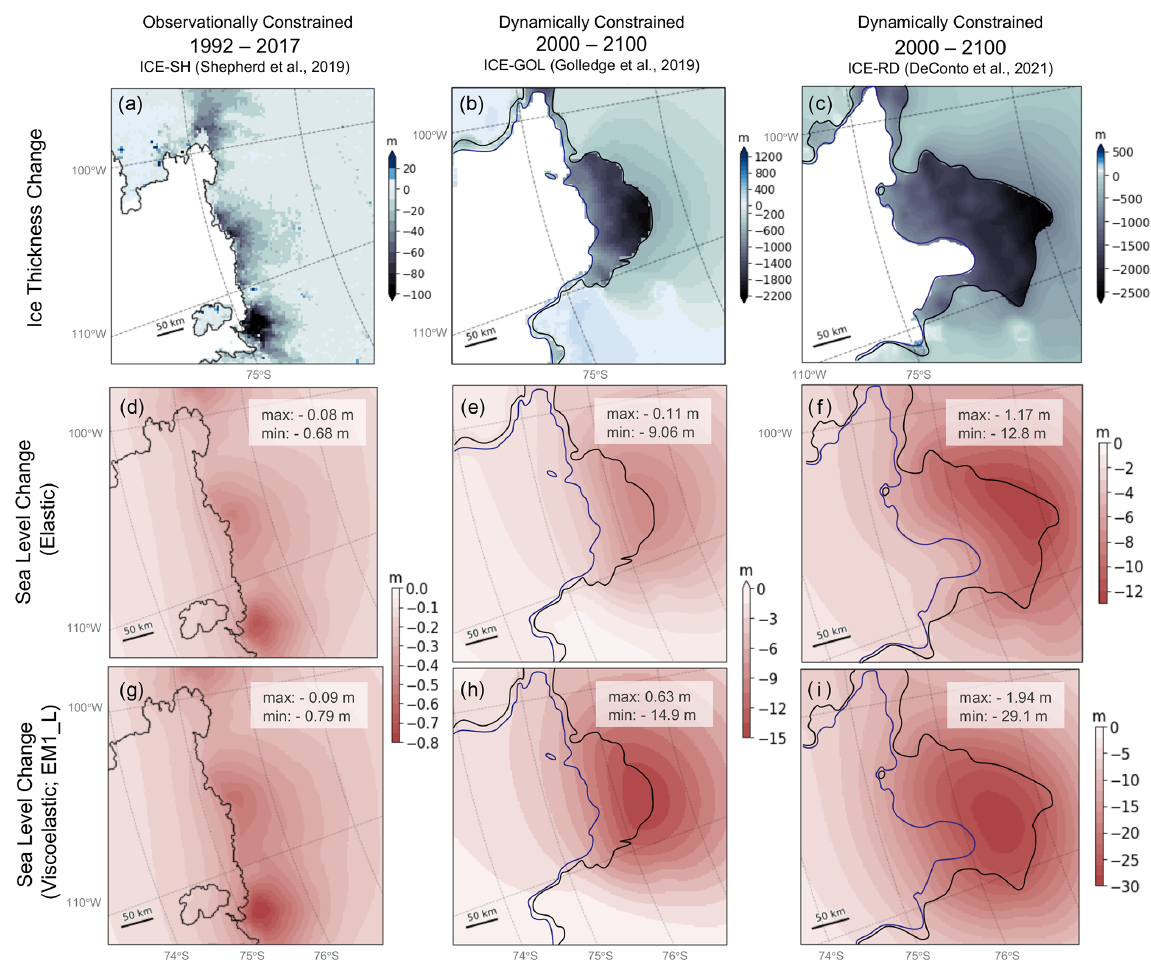
Figure 2. Ice loading scenarios and corresponding elastic sea-level predictions in the ASE. (a–c) Total ice thickness change in metres predicted from (a) 1992 to 2017 in the observation-based ICE-SH ice model (Shepherd et al., 2019) and from (b) 2000 to 2100 in the ICE- GOL (Golledge et al., 2019) and ICE-RD (DeConto et al., 2021) ice model projections. Panels (d–f) show the predicted sea-level change in metres with an elastic Earth model associated with the ice cover changes shown in (a–c) . Panels (g–i) are as in (d–f) but adopting 3-D viscoelastic Earth model EM1_L. All sea-level predictions were performed on a 1.9km resolution grid. The black and blue lines indicate final and initial grounding lines, respectively, for each simulation. Each panel is annotated with the maximum and minimum value within the panel. Note that the colour bars change across each